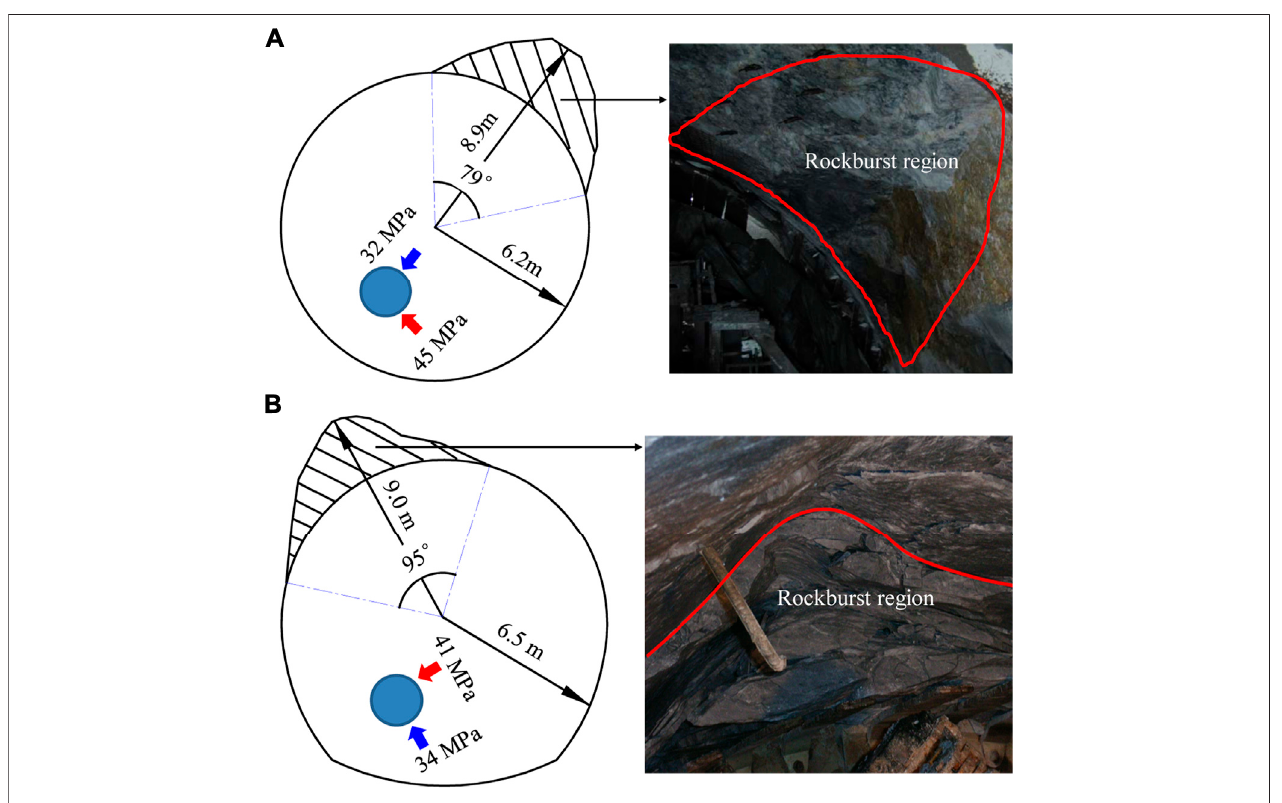
FIGURE2| Rockburst occurred duringexcavation ofdiversiontunnels at Jinping IIhydropower project. (A) AtNo.1diversion tunnel, (B) AtNo.2diversion tunnel.